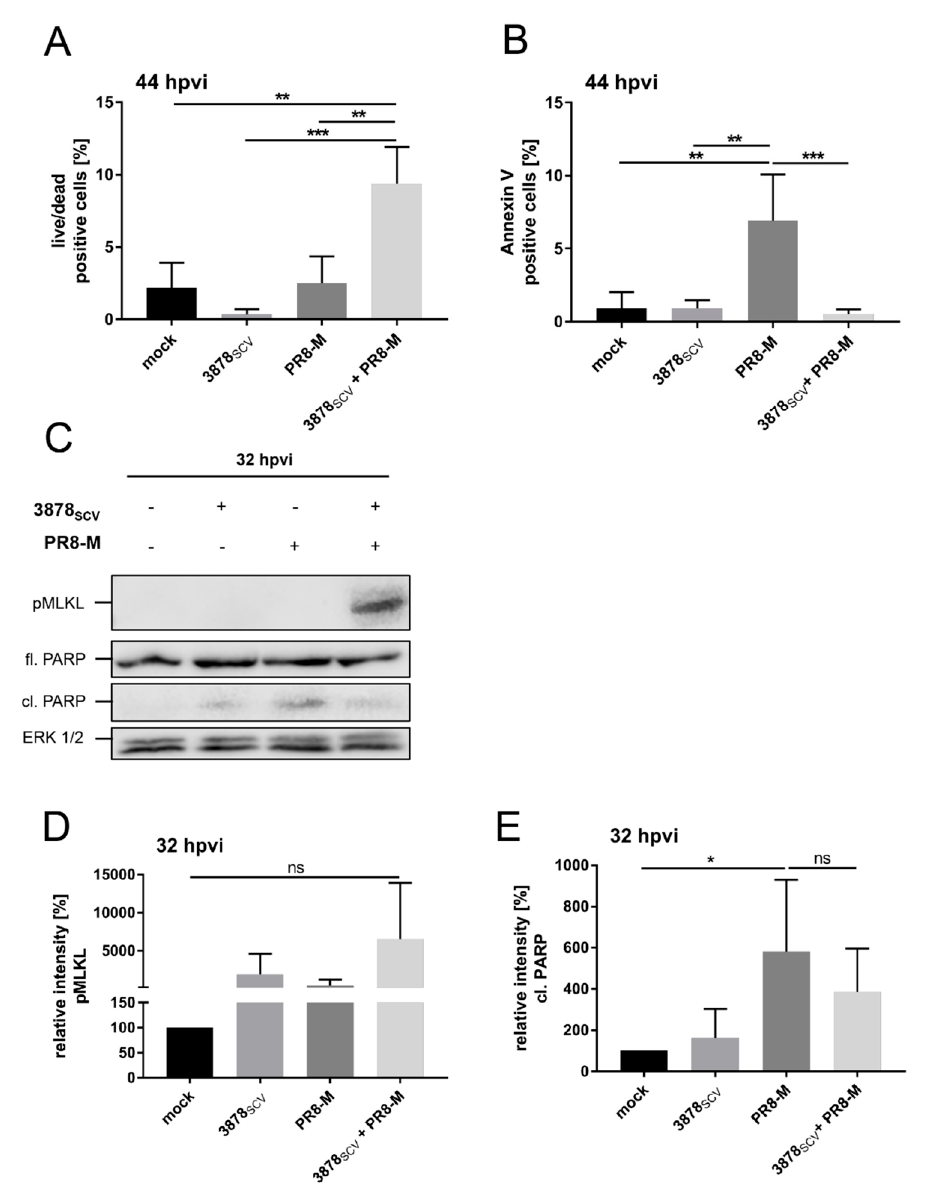
Figure 6. S. aureus 3878 SCV colonization and subsequent IV infection inhibits IV-induced apoptosis but results in the induction of necrosis. ( A – E ) A549 human lung epithelial cells were infected with S. aureus 3878 SCV (MOI = 0.01) for 24 h and / or super-infected with IV PR8-M (H1N1; MOI = 0.1) for 44 hpvi ( A , B ) or 32 hpvi ( C – E ). At the indicated times post-viral infection, total amount of cells was collected to perform FACS analysis to determine the relative amount of viability marker positive cells ( A ) or annexin V positive cells ( B ). Furthermore, whole cell lysates were subjected to western blot analysis ( C ). ( D , E ) Densitometrical analysis of three independent western blot experiments of cleaved pMLKL ( D ) and PARP ( E ) 32 hpvi are shown. Equal protein amounts were calculated by correlating the signal intensities to their corresponding ERK1 / 2 signals. Means + SD of three independent experiments are shown ( n = 3). Statistical significance was analyzed by a one-way ANOVA, followed by Tukey’s multiple comparison test ( A , B , D , E ); (* p < 0.05, ** p < 0.01, *** p < 0.001); (hpvi = hours post-viral infection; ns = not significant).